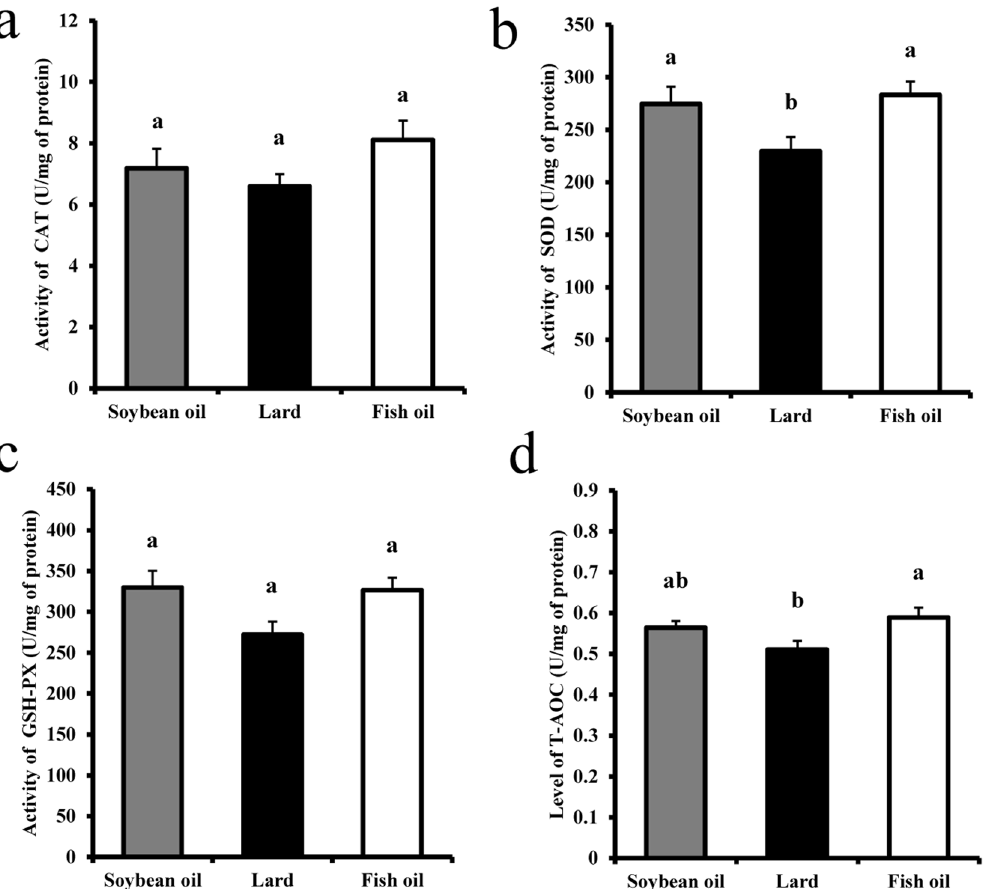
Figure 2. Antioxidant enzyme activities level of rats fed with soybean oil, lard and fish oil diets. ( a ) Catalase activity; ( b ) Superoxide dismutase activity; ( c ) Glutathione peroxidase activity; ( d ) Total antioxidant capacity. Values are shown as means ± SE (n = 11). Different letters indicate significant difference ( P <